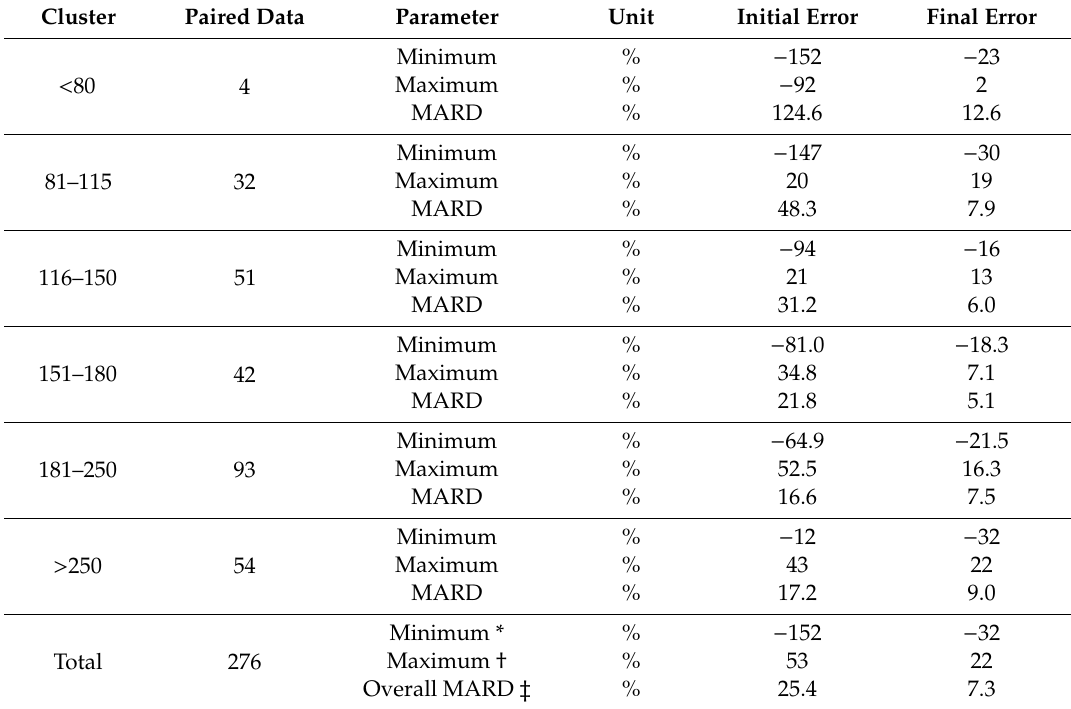
Table 10. Results of the PGMS applied to dataset 1.